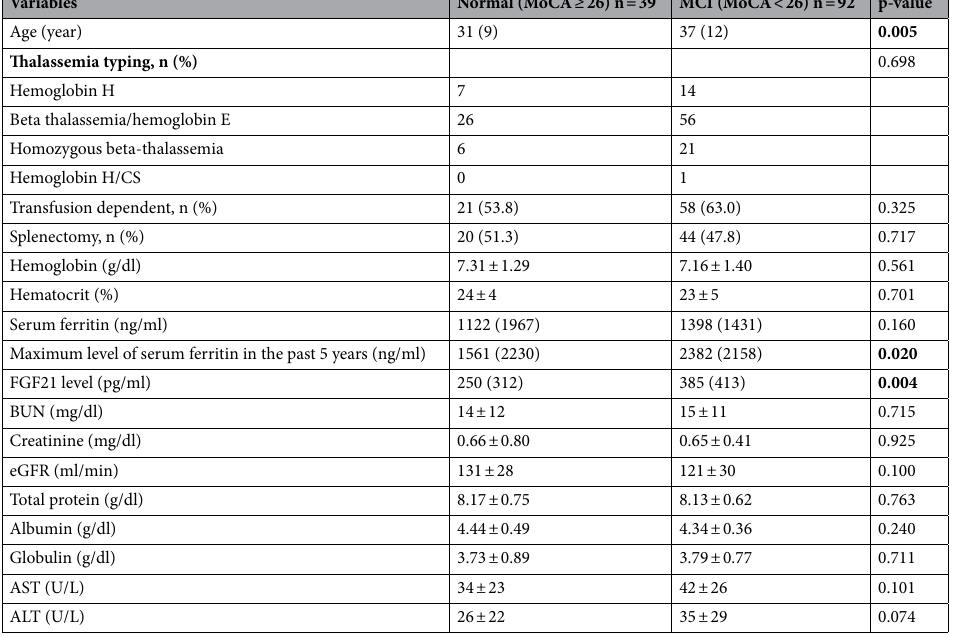
Table 2. Demographic data among normal and mild cognitive impairment group. Data were represented by mean ± SD, whereas data from serum ferritin, maximum level of serum ferritin in the past 5 years, and FGF21 level were represented as median and IQR. Montreal Cognitive assessment. MCI mild cognitive impairment, FGF21 fibroblast growth factor 21, BUN blood urea nitrogen, eGFR estimated glomerular filtration rate, AST aspartate aminotransferase, ALT alanine aminotransferase.